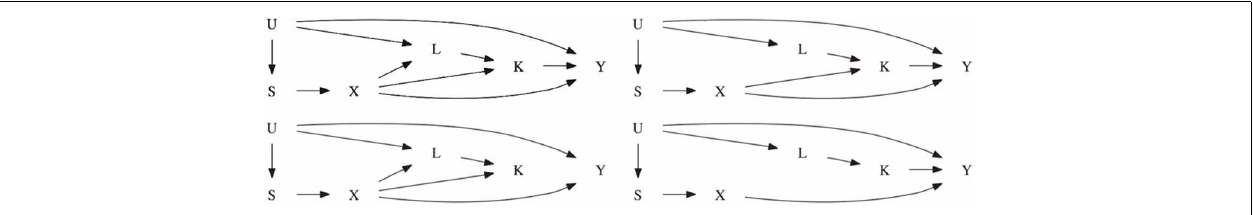
as scenario 1 except that K does not cause Y . The bottom right figure represents scenario 4 which is the same as scenario 2 except that X does not cause K